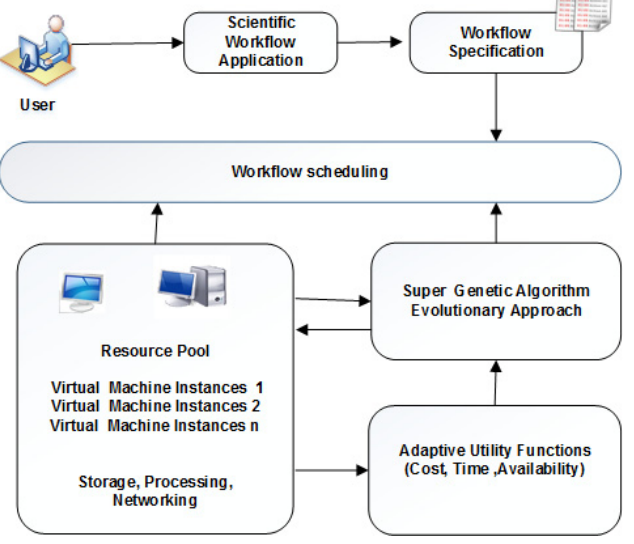
Fig. 1. System model of work°ow scheduling system in